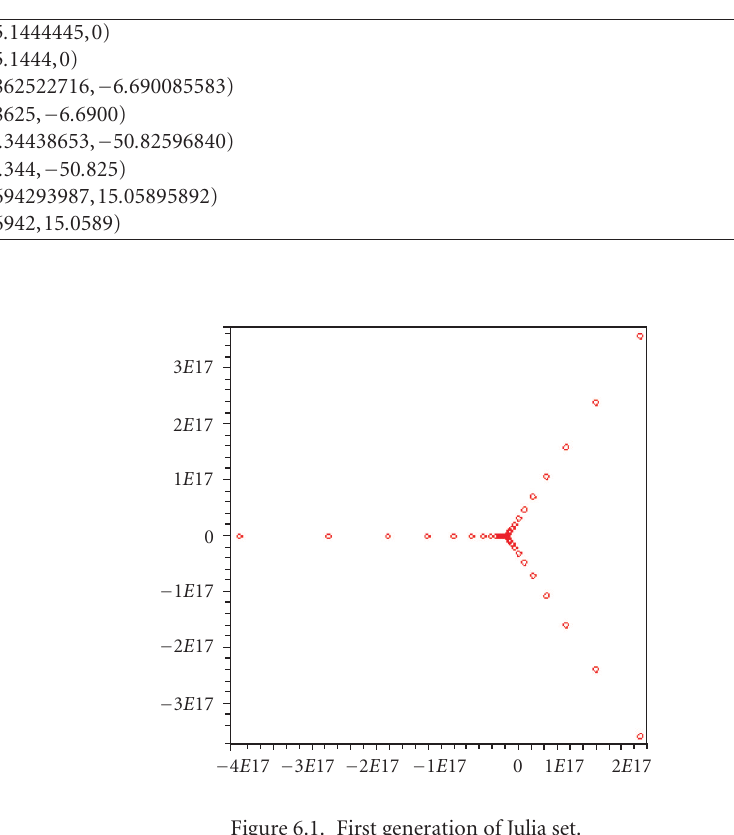
Figure 6.1. First generation of Julia